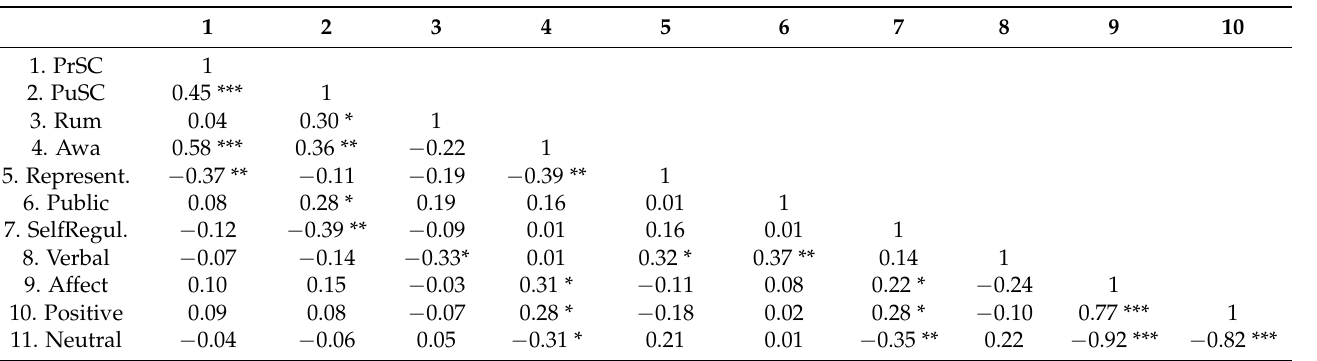
Table 3. Correlations between DSC and SSA